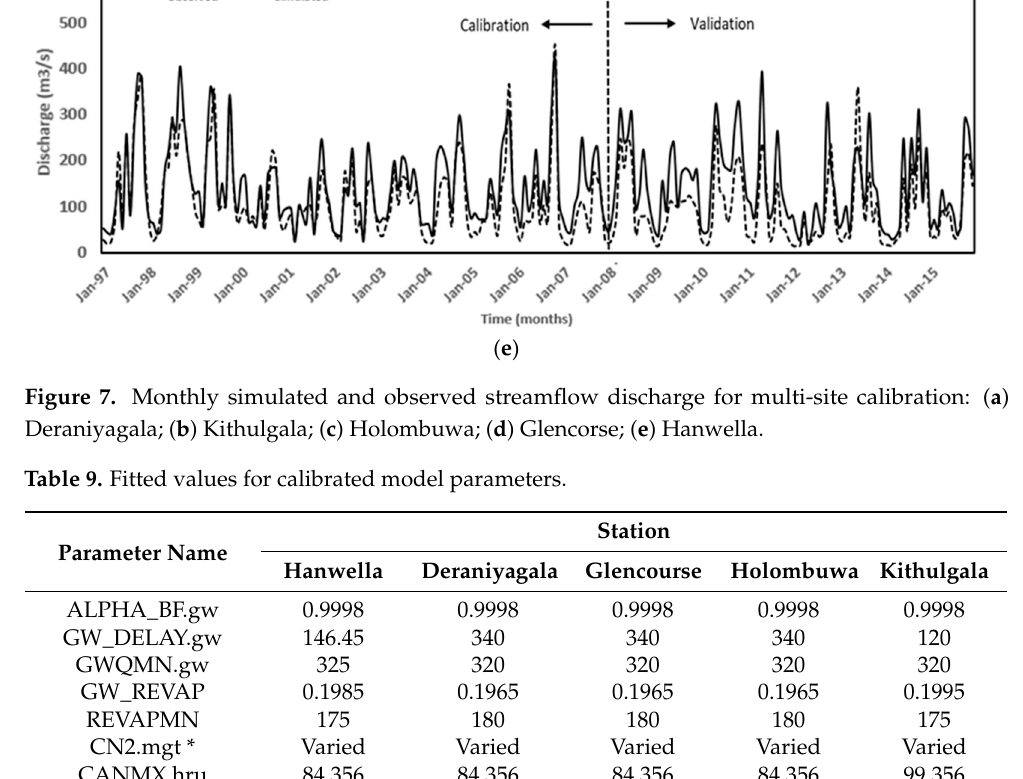
Table 8. Performance evaluations for the monthly discharge simulation.